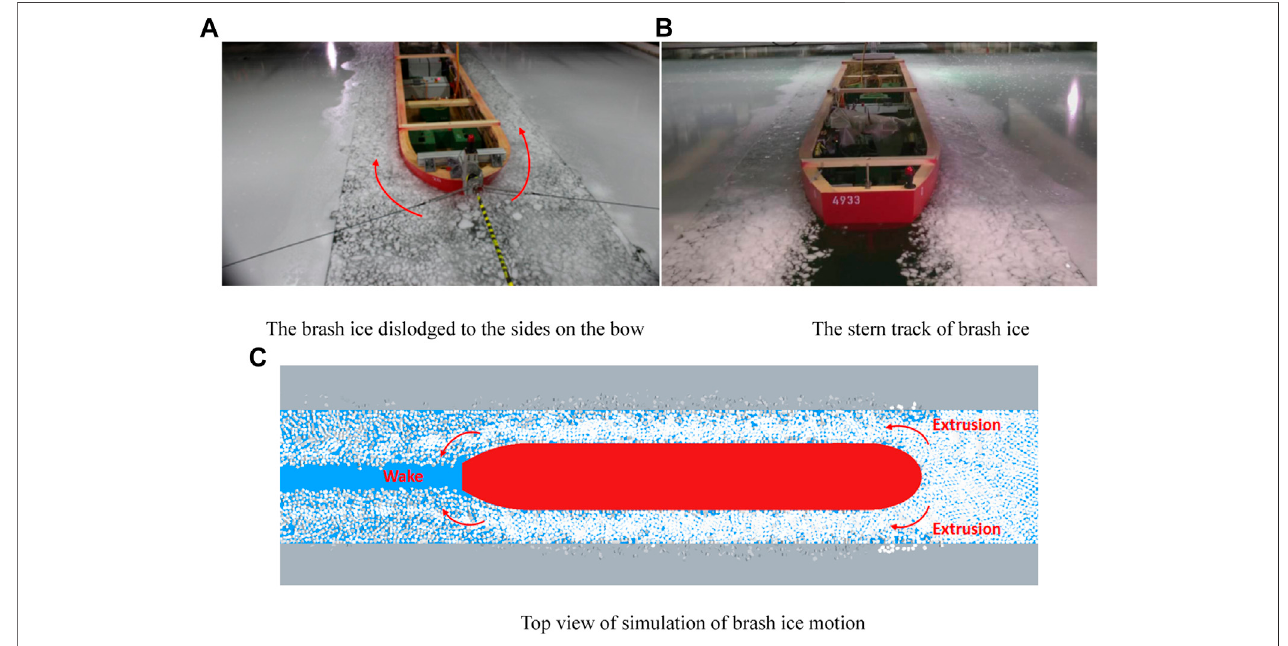
FIGURE 10 | Comparison between numerical simulation and ice tank test when h i = 46.3 mm.